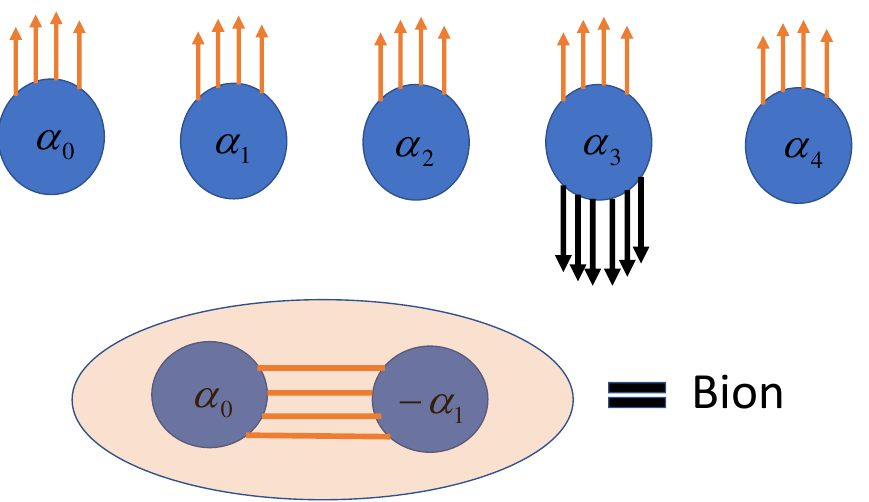
Figure 10 . The monopoles and their zero modes in su (5) with n G = 2 ; N F = 3. A monopole and anti-monopole can soak up their adjoint fermion zero modes to result in a magnetically charged bion. The (cid:11) 3 monopole has additional fundamental zero modes, and hence, it does not participate in the formation of any magnetically charged